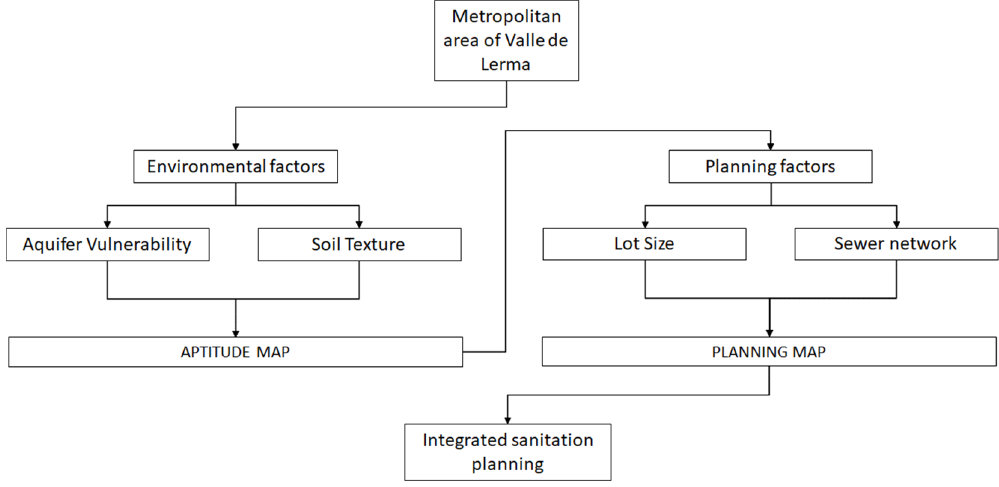
Figure 2. Methodological flow chart with factors and elements considered in the SDSS.